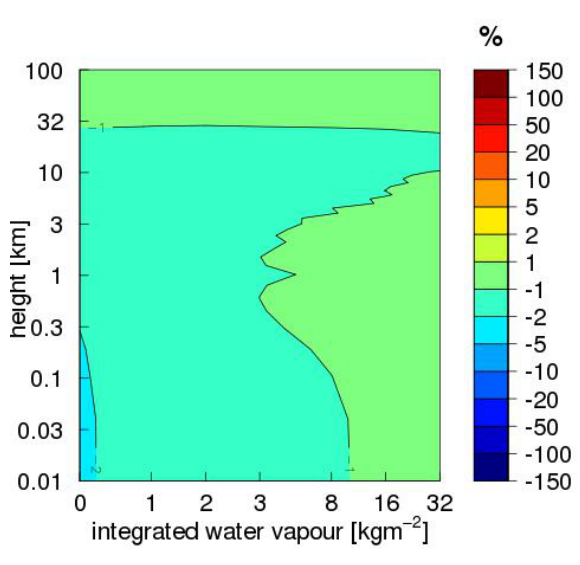
Figure 2. Experiment 1: relative differences (%) in net fluxes be- tween the IFS radiation scheme and Kato-DISORT shown as a func- tion of integrated water vapour and height.